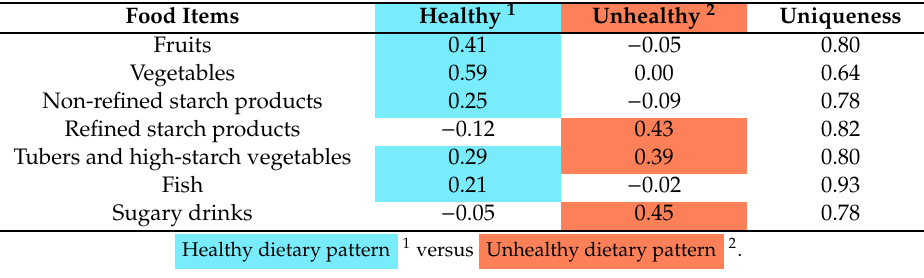
Table 3. Food grouping factor loadings by dietary